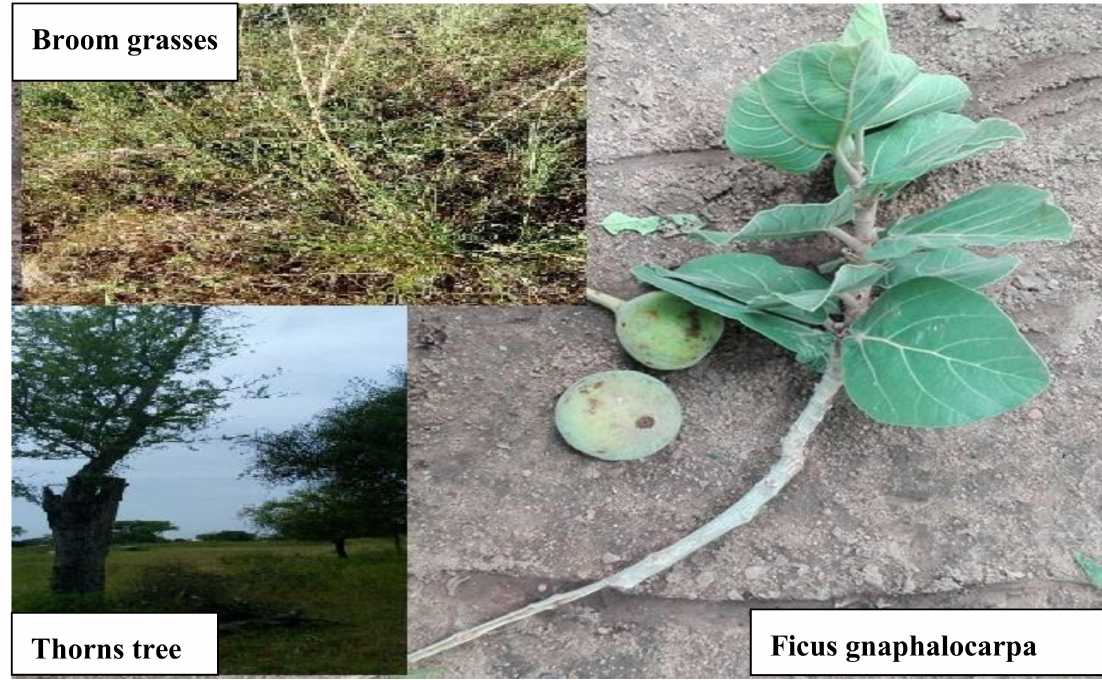
Figure 4. Groundwater indicators in